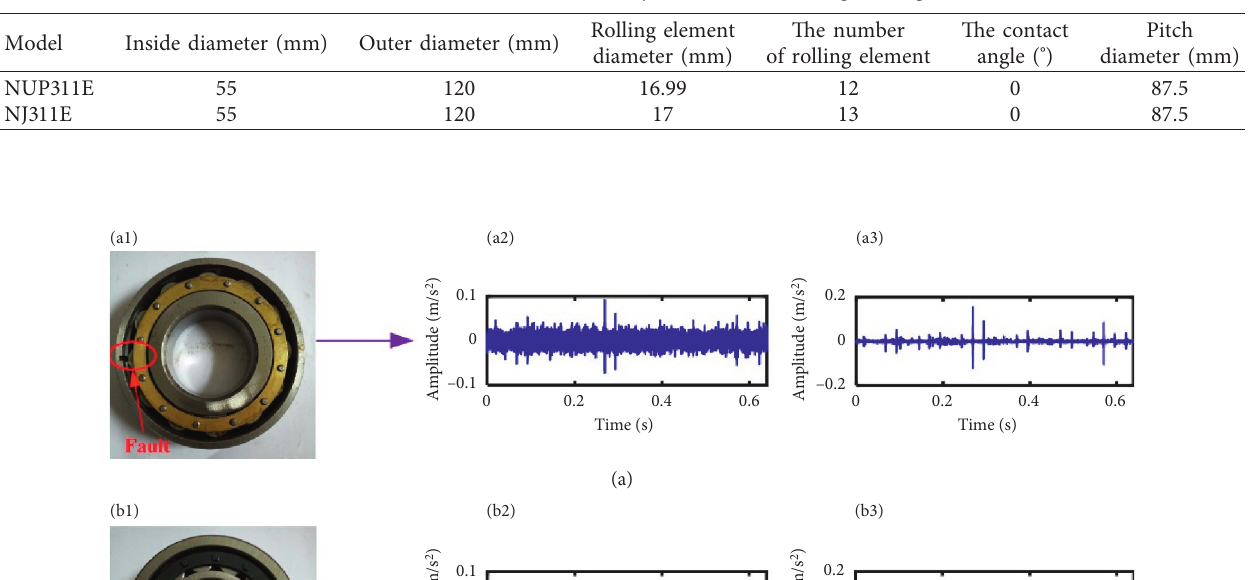
Table 1: Parameters of NUP331E cylindrical roller rolling bearing.